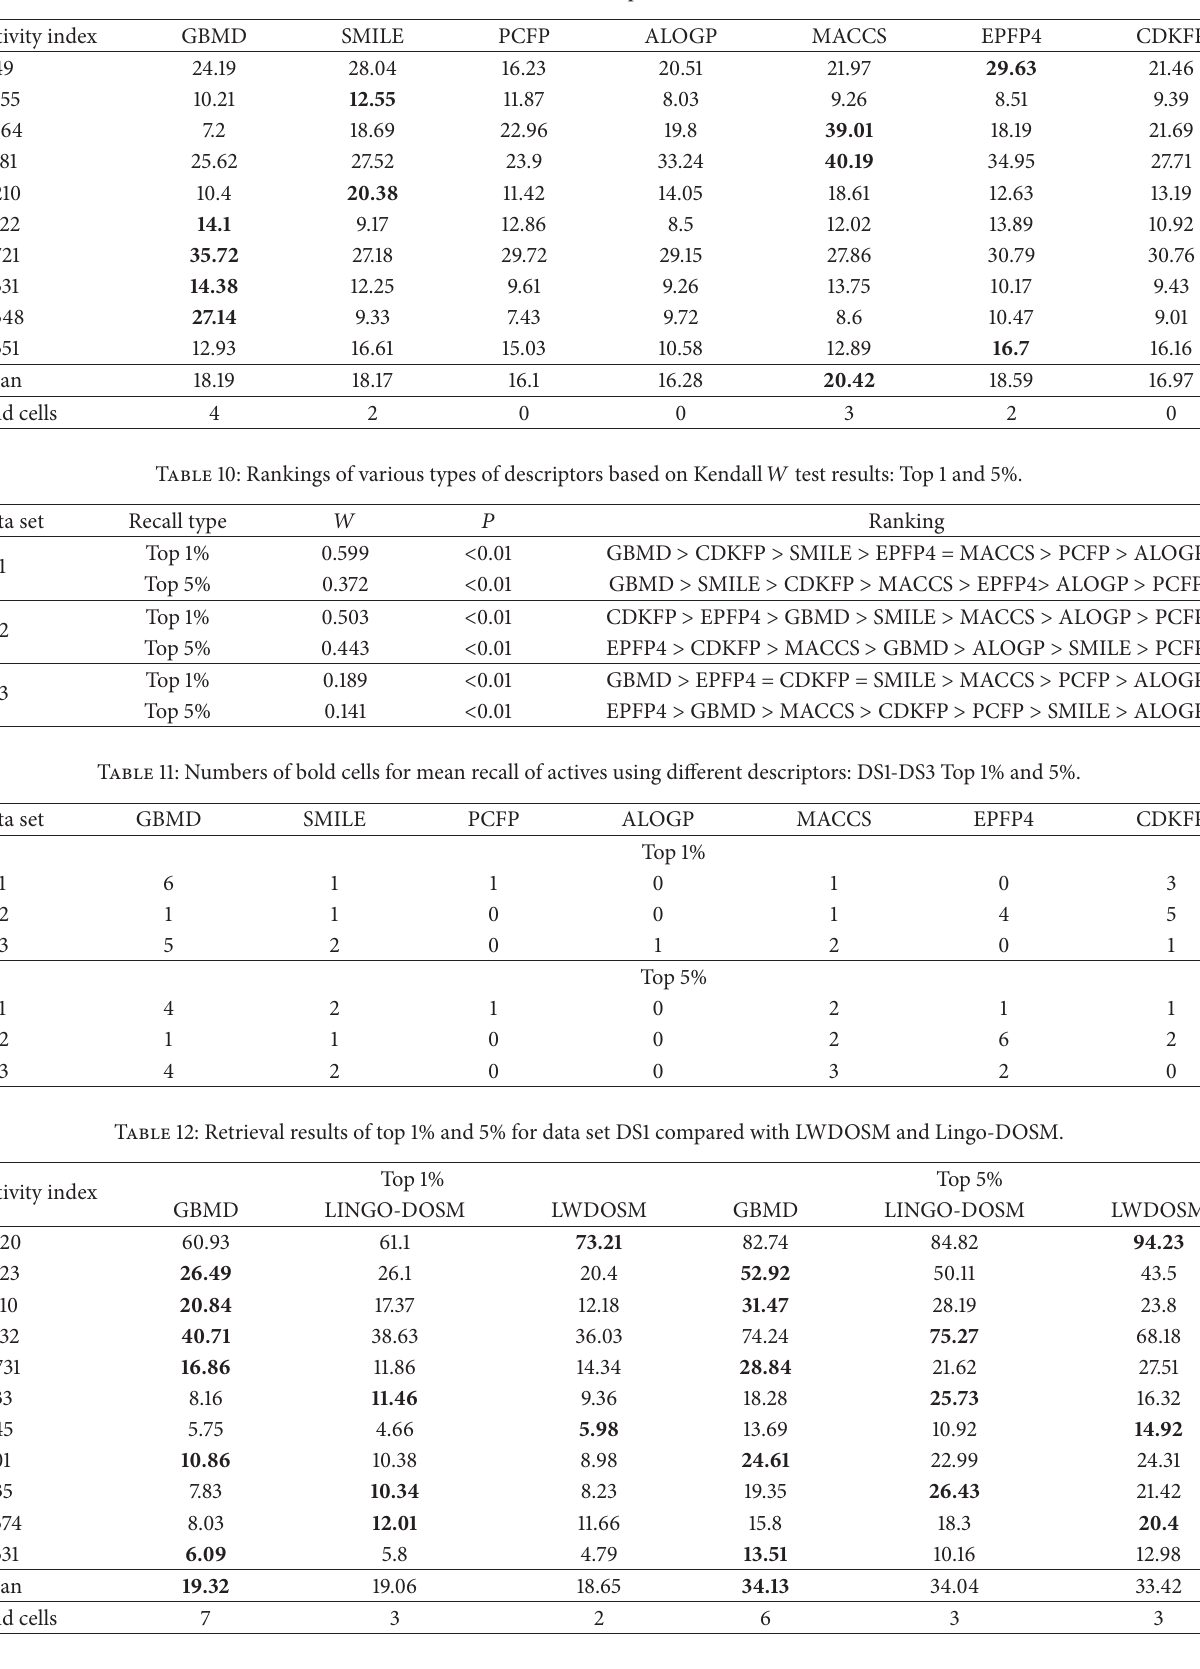
Table 9: Retrieval results of top 5% for data set DS3.